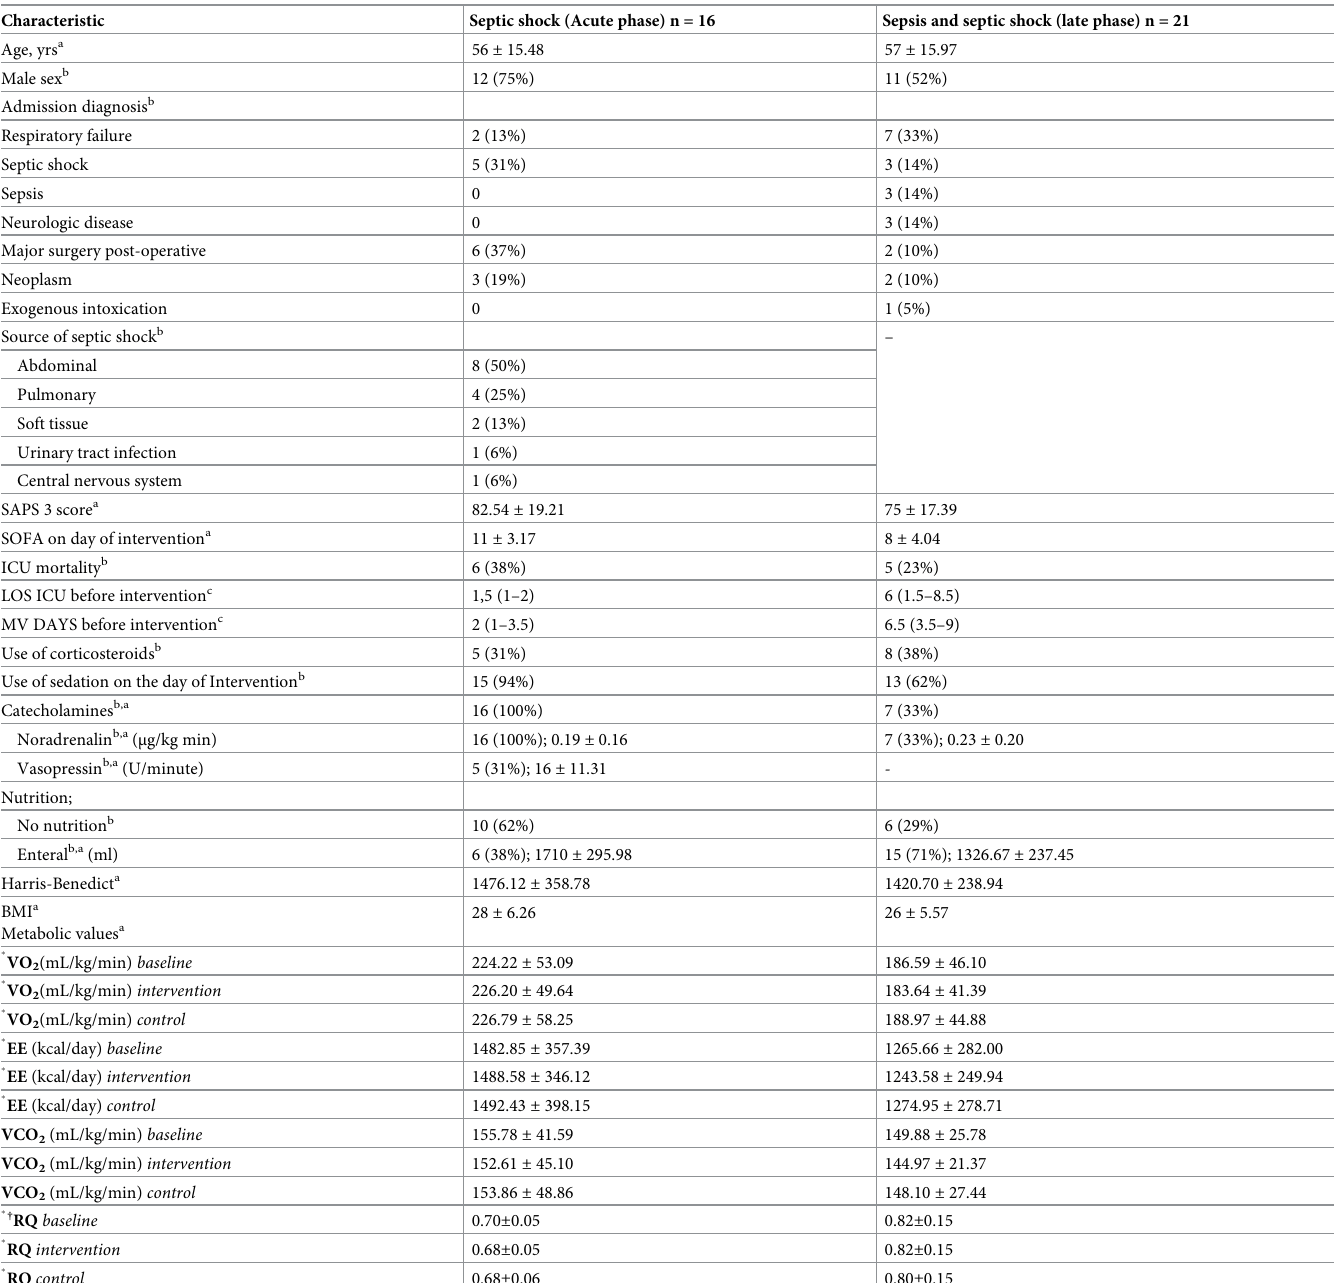
Table 1. Demographic and clinical data of